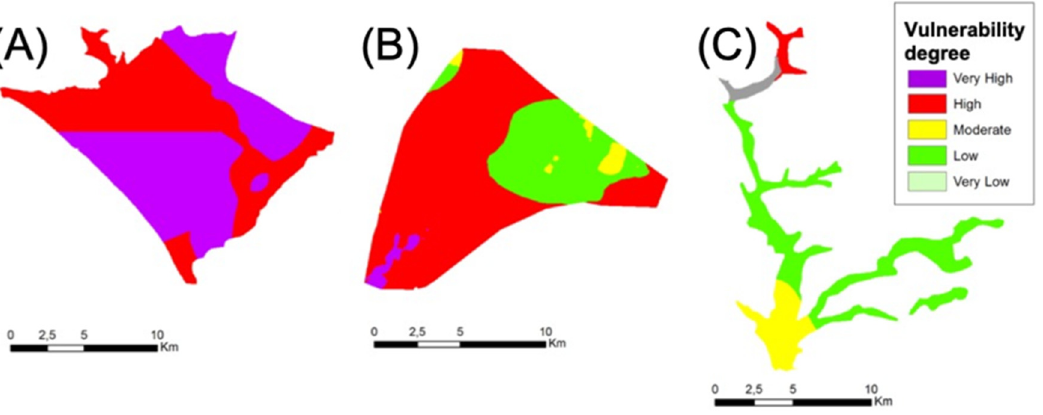
Figure 8. Vulnerability maps for ( A ) Garigliano River plain; ( B ) Campanian plain-Acerra; and ( C) Alento plain (in grey reservoir area), drawn according to the reclassified AVI method.